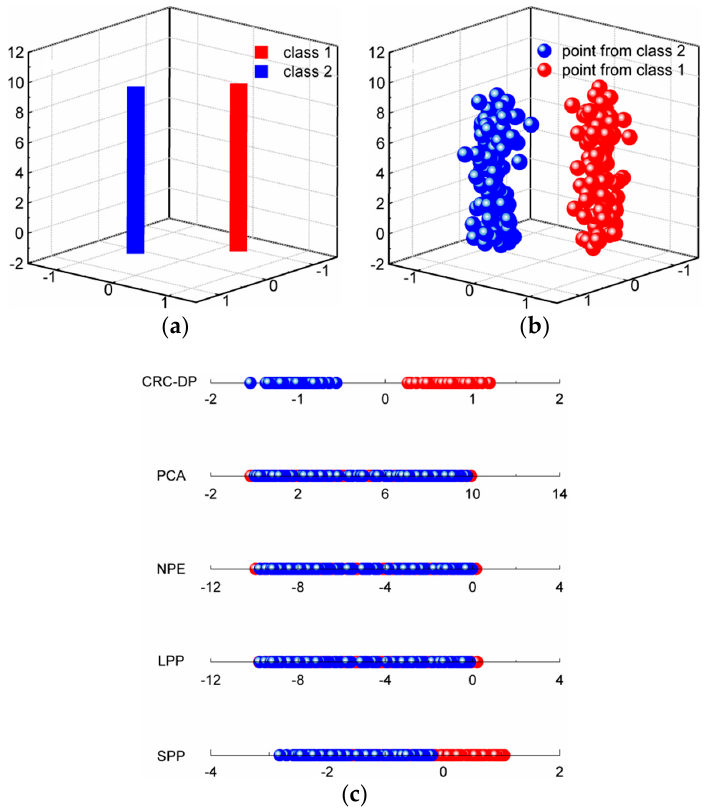
Figure 2. ( a ) Two classes of data; ( b ) 100 points from each class; ( c ) the one-dimensional results using different DR methods.